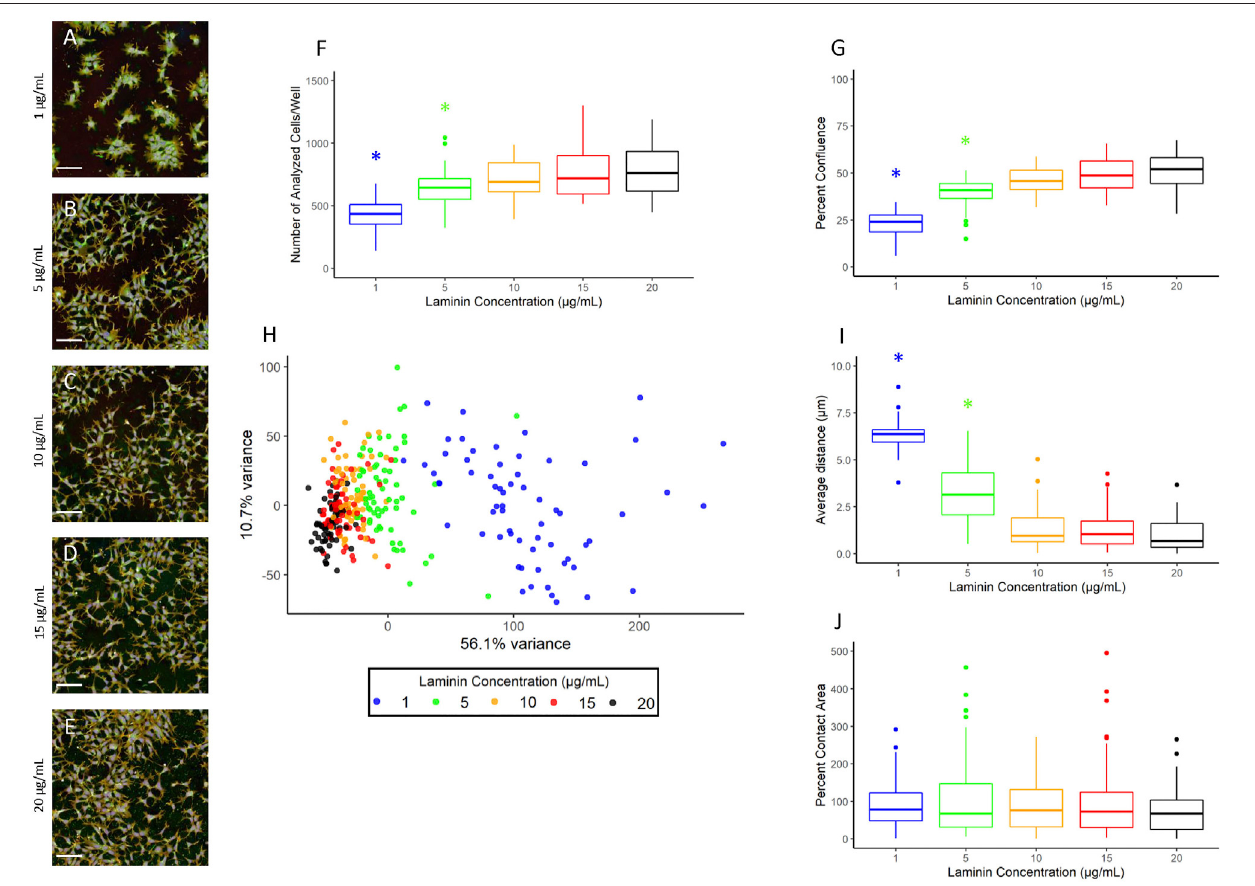
FIGURE 3 | Laminin titer. Images were captured with a 20X water immersion objective and Harmony ® software was used for further processing. A representative composite image ofthehNP1 cells cultured on 1 (A) ,5 (B) , 10 (C) , 15 (D) , and 20 (E) µg/mL lamininisdisplayed. Well-level data wereexported toassess the number of analyzed cells/well (F) and percent con fl uence (G) , whereas cell-level data were exported for the PCA (H) and evaluation of individual positional features (I,J) . Graphs represent four biological replicates (i.e., independent cultures) which includes 16 technical replicates/concentration per biological replicate. The x - and y -axes on theprincipalcomponentgraphdepictthevarianceinthe fi rstandsecondprincipalcomponent,respectively.Allstatisticalcomparisonsweremadeto20 µg/ml(adjusted p -value, * p < 0.05). Scale bar = 100 µm.